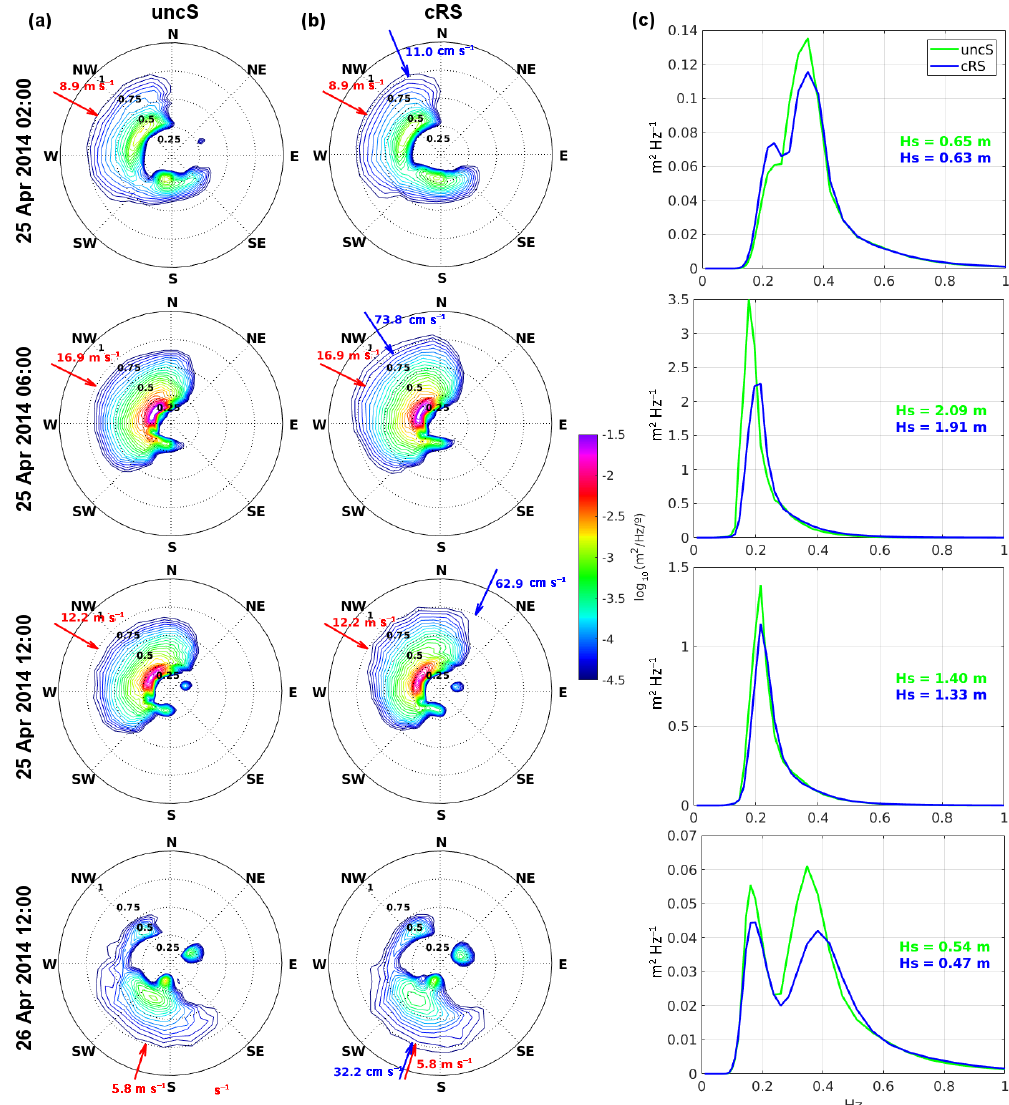
Figure 10. Spectra evolution during the E3 event at P2. (a) 2-D spectrum from uncS run. (b) 2-D spectrum from cRS run. (c) 1-D spectra from both runs and the corresponding Hs values. The arrows shown in panels (a) and (b) indicate the direction and magnitude of wind (red) and current